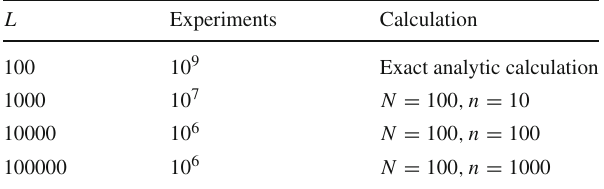
Table 1 The Monte Carlo data sets generated. The length of the sequences and the numbers of simulated experiments are given. The last column gives the parameters used for the calculation